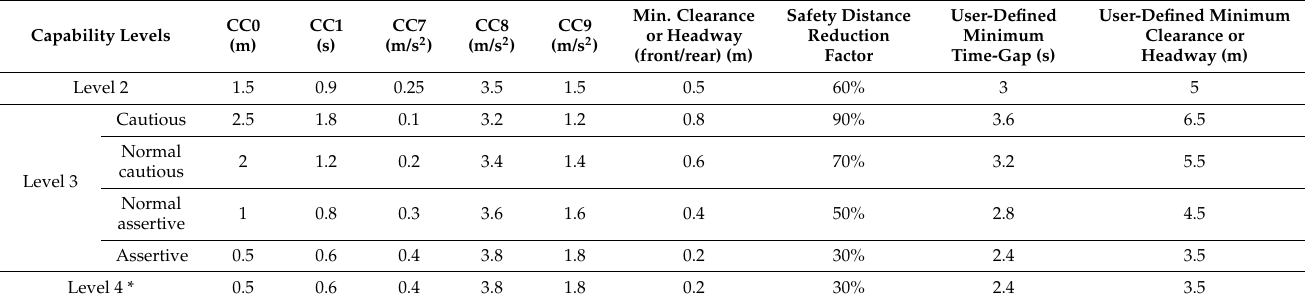
Table 8. Parameter variation for Wiedemann model and VISSIM user-defined attributes